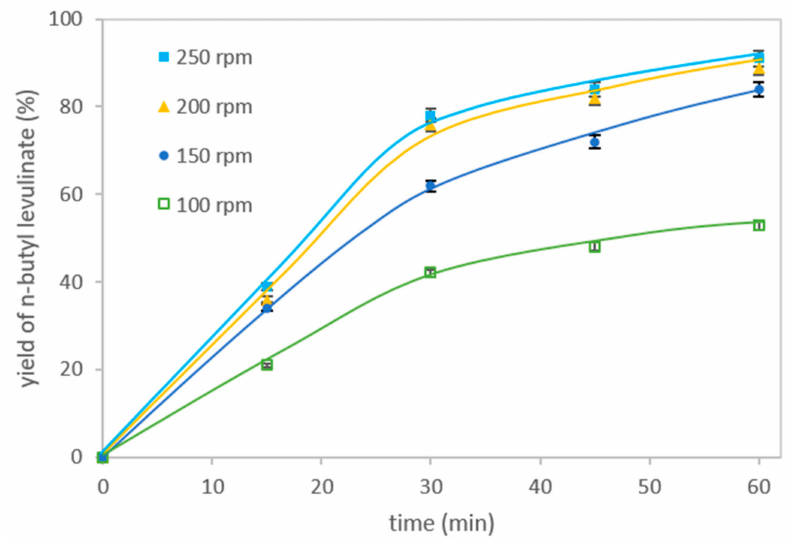
Figure 1. The effect of agitation speed on LA esterification. Reaction conditions: LA (0.117 g, 1 mmol); n -butanol (0.148 g, 2 mmol); biocatalyst CALB/MWCNT-PTFE (0.10 wt.%) (150 mg); n -hexane (1 mL); 20 ◦